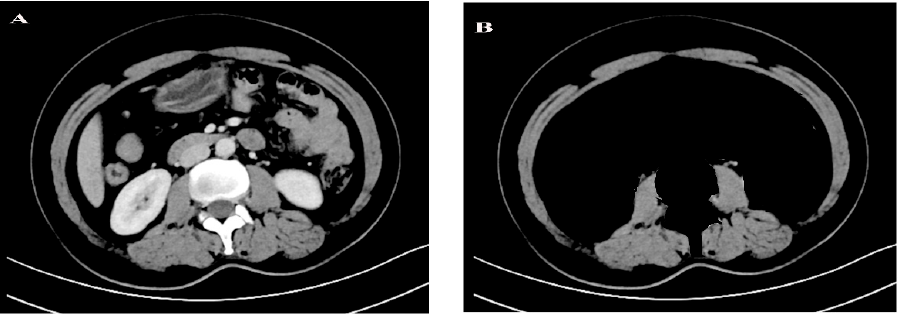
Figure 1. An example of abdominal computed tomography (CT) image. ( A ) The original CT image. ( B ) Skeletal muscle are quantified range of ( − 29 to + 150 Hounsfield units), and they were outlined along the epimysium that surrounded the muscles.